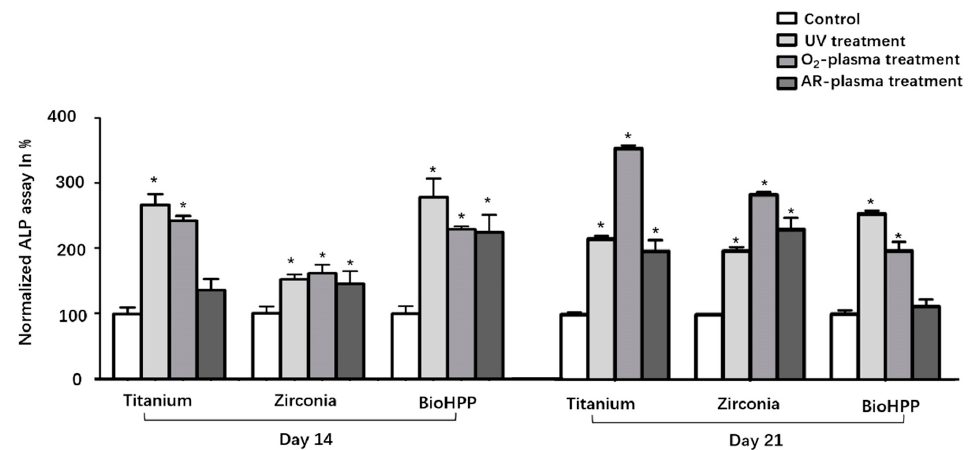
Figure 4. ALP activity of osteoinductive DPSCs on different surface treated titanium, zirconia and BioHPP after 14 and 21 days. ALP activity was increased in general after UV light and NTP treatment compared to control groups. The increase in ALP between the experimental groups and their corresponding control group was statistically significant except for the argon treated surface of titanium at 14 days and BioHPP at 21 days. * p < 0.05.